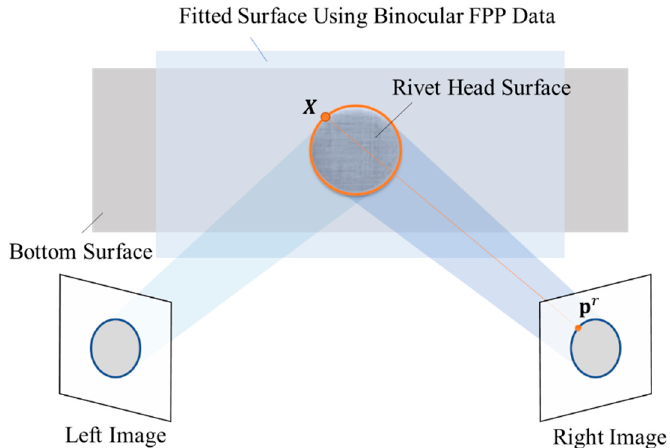
Figure 3. Principle of edge reconstruction by combining dual camera FPP 3-D data and monocular image contour. The orange line illustrates the 3-D coordinates solving of the right camera, where the spatial point X is the intersection between fitted plane and camera ray. The same procedure can also be applied to the left image.